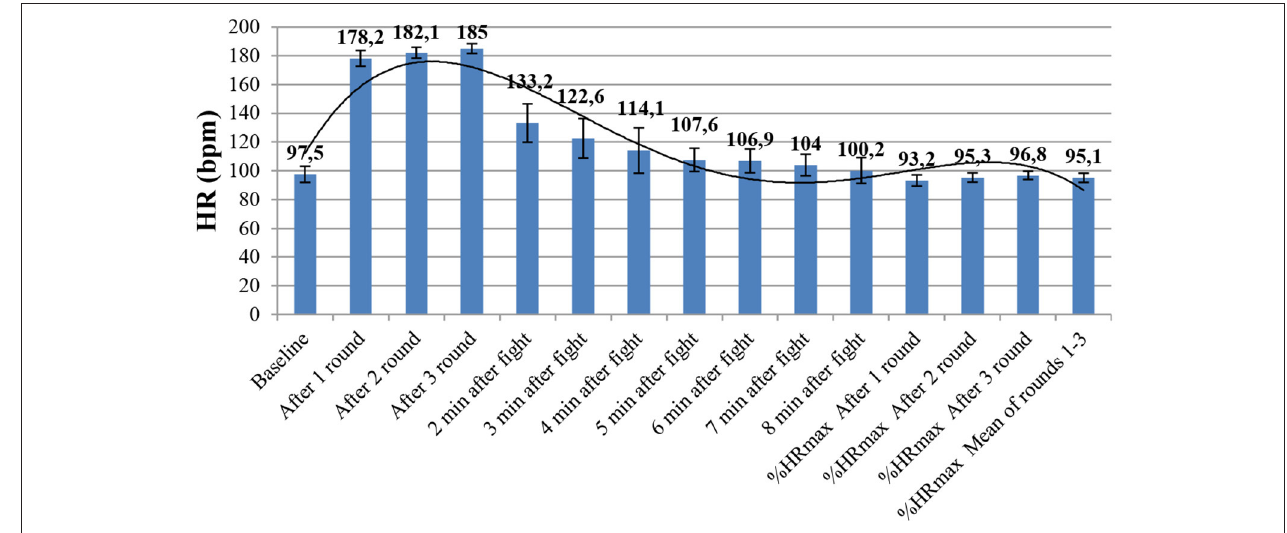
FIGURE 3 | Heart rate in subsequent measurements.